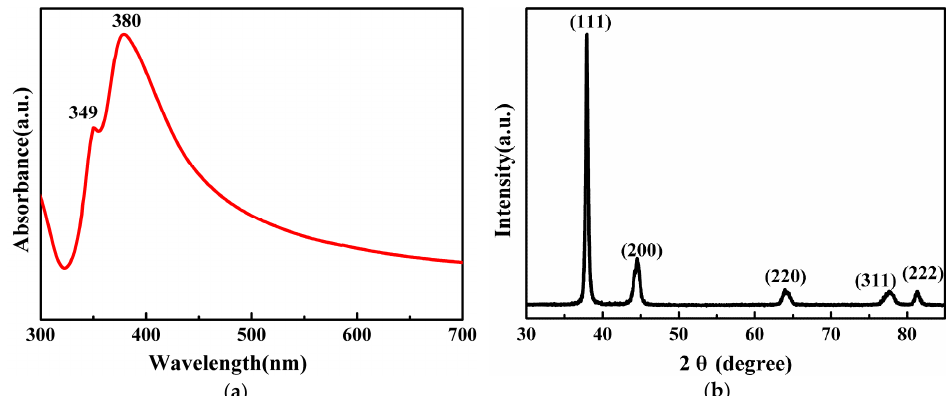
Figure 2. ( a ) Ultraviolet ‐ visible (UV ‐ Vis) absorbance spectrum of silver nanowires; ( b ) X ‐ ray diffraction (XRD) pattern of silver